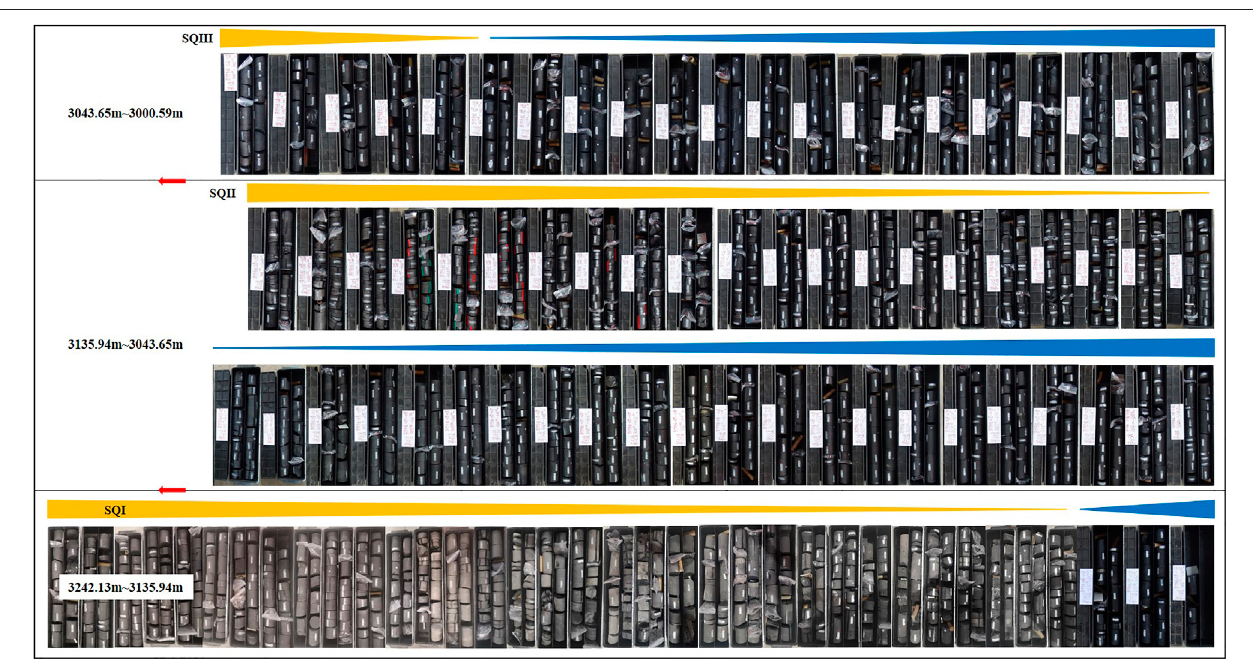
FIGURE 2 | Macroscopic characteristics of cores in the whole section of Qiongzhusi Fm, W-207 Well. The Qiongzhusi Fm can be divided into three third-order sequences.SQI:Firstmember ofQiongzhusiFm(